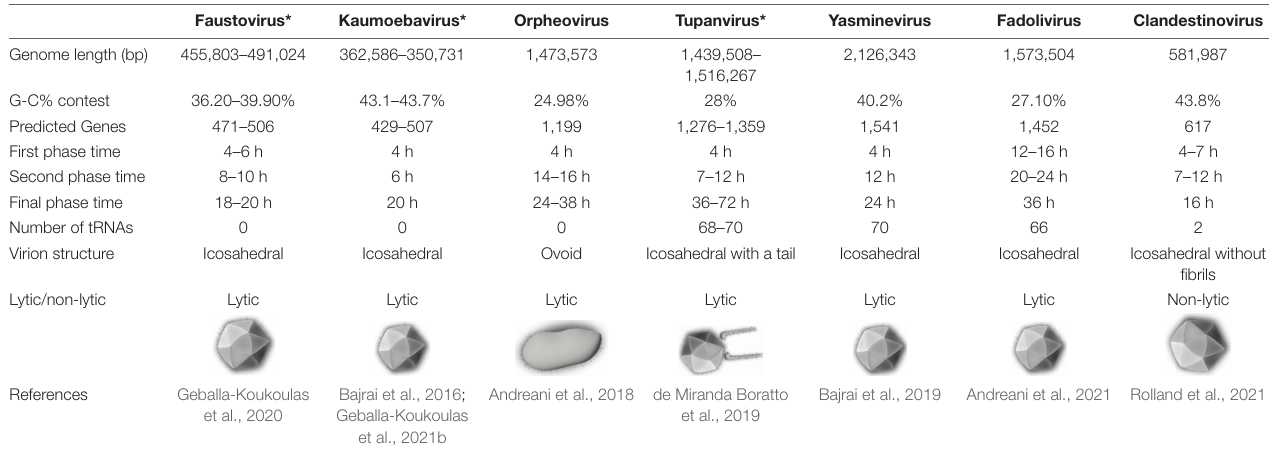
TABLE 1 | General features of all Vermamoeba- infecting viruses, recognized and/or potential members of the phylum Nucleocytoviricota